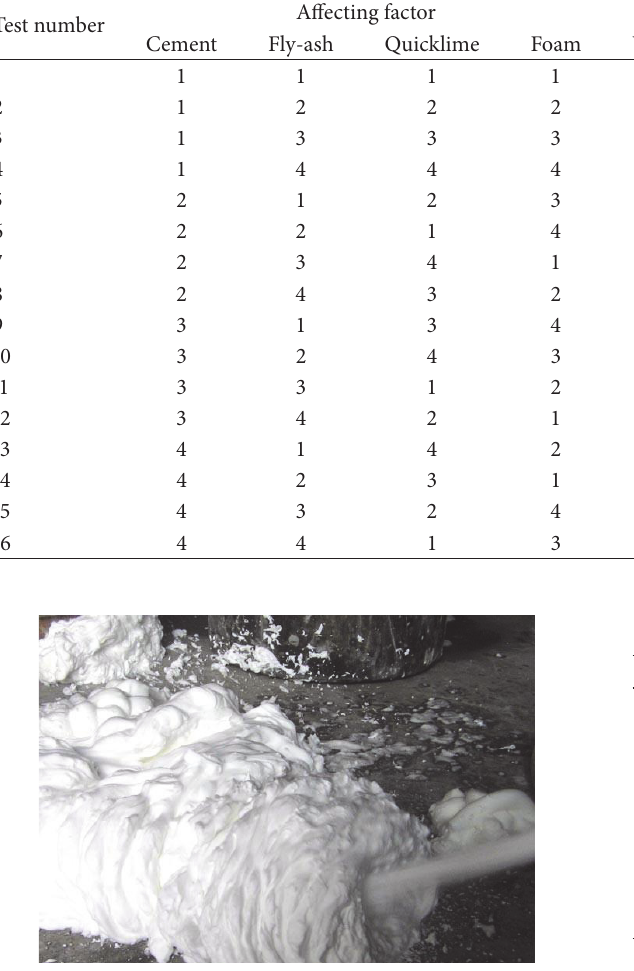
Table 4: Physical properties of